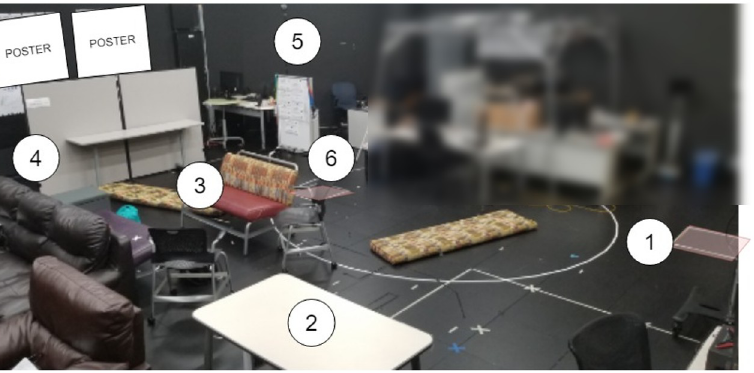
Fig 15. View of the experimental setup for user study 2 for presentation. Posters are blanked to preserve anonymity. The blurred area is associated with another research project irrelevant to this work.